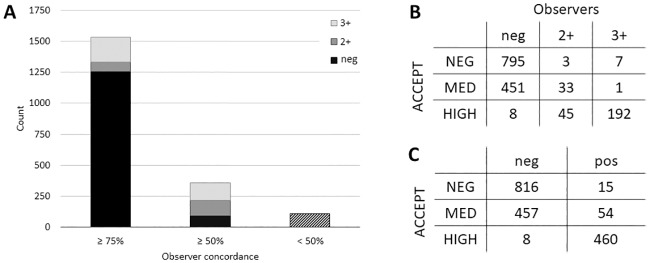
HER-2 scoring of 2000 CTC thumbnail IF images by 17 trained observers (0, 2+, 3+) versus ACCEPT (HER-2neg, HER-2med, HER-2high).A. ≥75% concordance between observers was reached for 1535 CTCs. For 358 CTCs agreement was reached between >50% of observers, and for 107 CTCs (dashed box) no agreement was reached B. HER-2 scores of 1535 CTCs given by ≥75% of observers versus ACCEPT. HER-2-negative CTCs according to observers were mainly scored HER-2neg or HER-2med by ACCEPT. HER-2high expressing CTCs by ACCEPT were predominantly scored 2+ or 3+ by the observers. C. HER-2 scores of 1810 CTCs given by ≥75% of observers versus ACCEPT. HER-2high expressing CTCs by ACCEPT were predominantly scored positive by the observers.